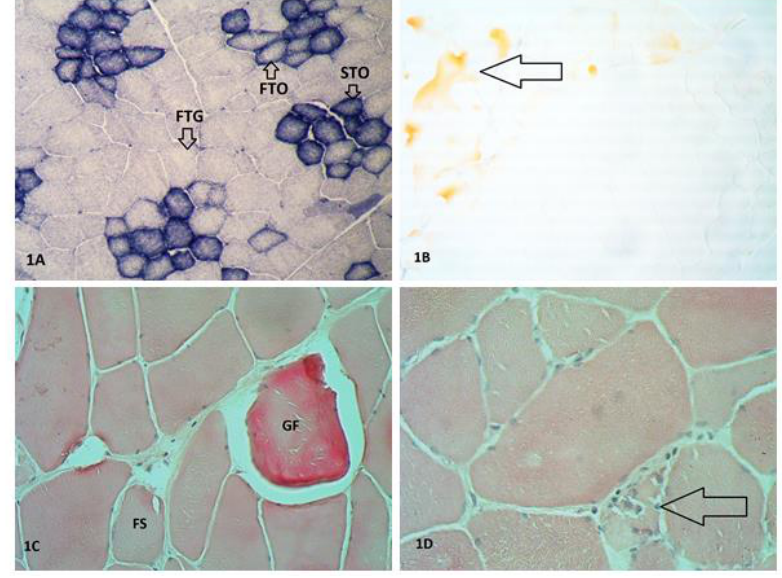
Figure 1. ( A ) muscle fiber types (group E1 + EM), NADH-TR tetrazolium reductase activity and